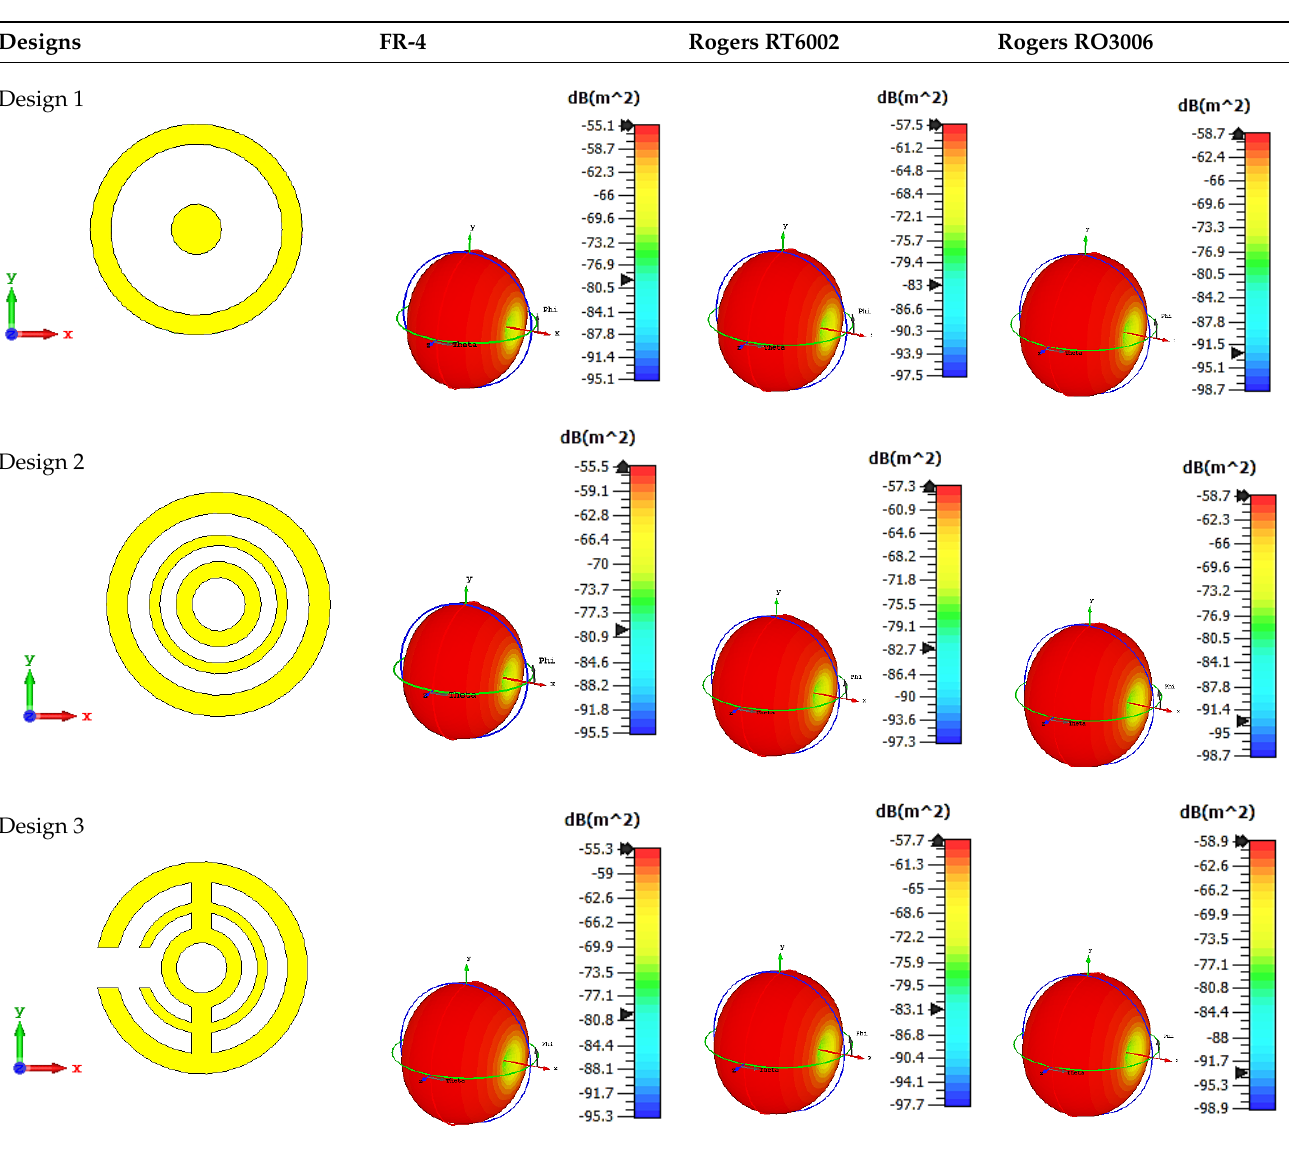
Figure 1. Monostatic RCS values for circular metamaterial unit-cell design with various substrate materials: ( a ) Design 1; ( b ) Design 2; and ( c ) Design 3. Table 1. Bistatic scattering patterns of circular structure with the various substrate materials.